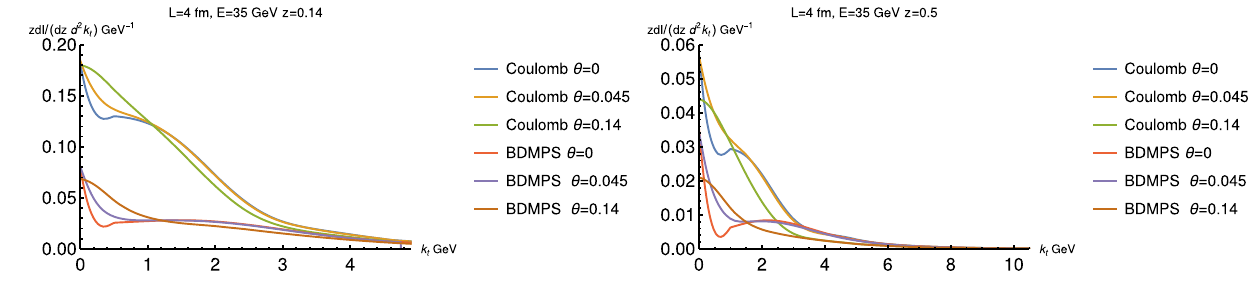
Fig. 6 The angular distributions z dI for different θ = 0 , 0 . 045 , 0 . 14 (corresponding to massless, charmed and bottom quarks) for E = 35 GeV dzd 2 k t and z = 0.14 (left), z = 0.5